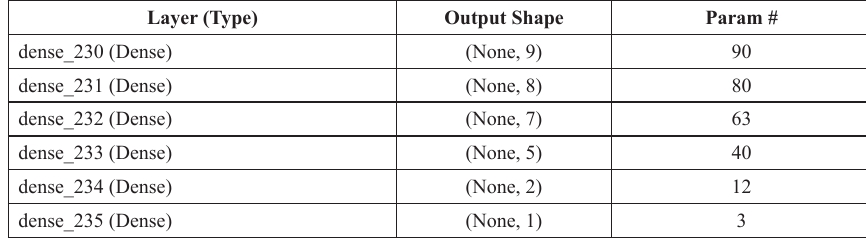
Table 6. Model summary and output shape for each